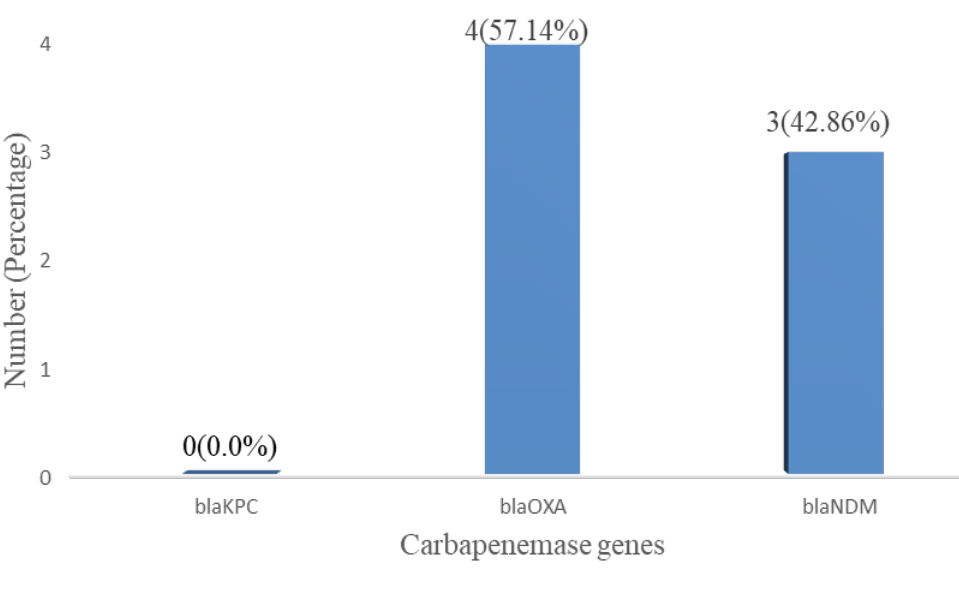
Figure 2. Percentage distribution of carbapenemase genes among carbapenem resistant